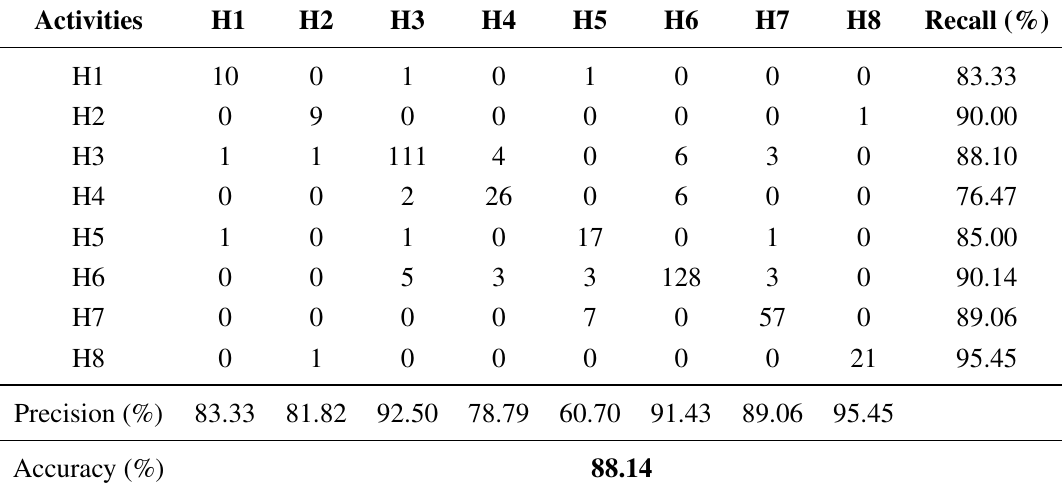
Table 8. Confusion matrix of the SVM classifier using MCTM for the horizontal